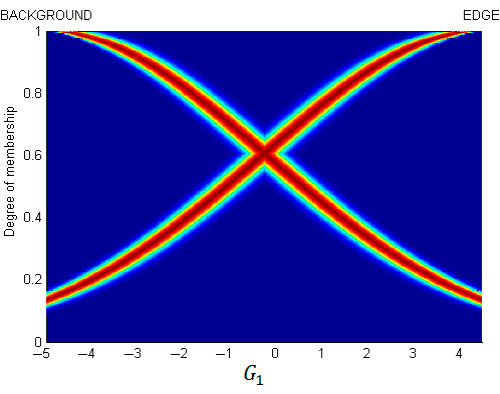
Figure 6. GT2 output membership function for the variable G 1 . Table 1. Knowledge base of nine fuzzy rules for edge detection process.